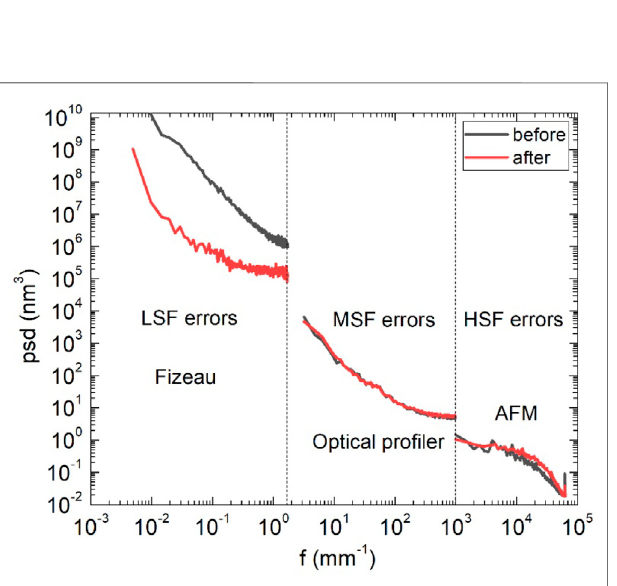
FIGURE 11 | PSD results of VFM before and after IBF as measured by the Fizeau interferometer, optical pro fi ler, and AFM.